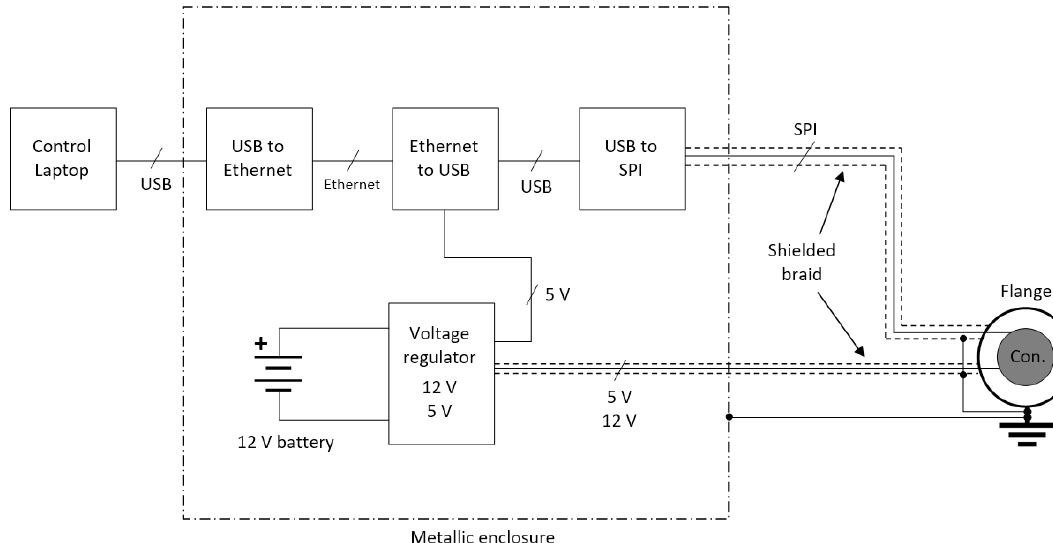
Figure 7. EGSE to test SLP and the PICASSO mock-up in the plasma